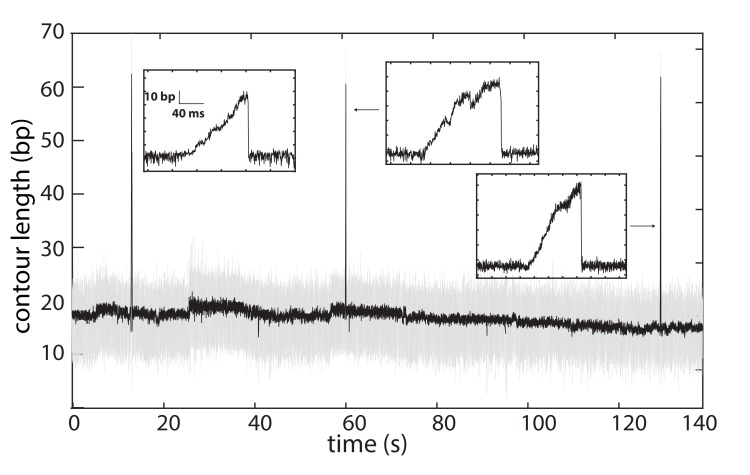
Multiple unwinding events by RecD occur on the same DNA molecular construct.Contour-time trace for long timescales shows peaks of RecD activity. Zoomed-in windows indicate individual activity events of RecD followed by dissociation. [ATP] = 2 mM. Raw data is shown in grey, filtered data (fc = 250 Hz) is shown in black.